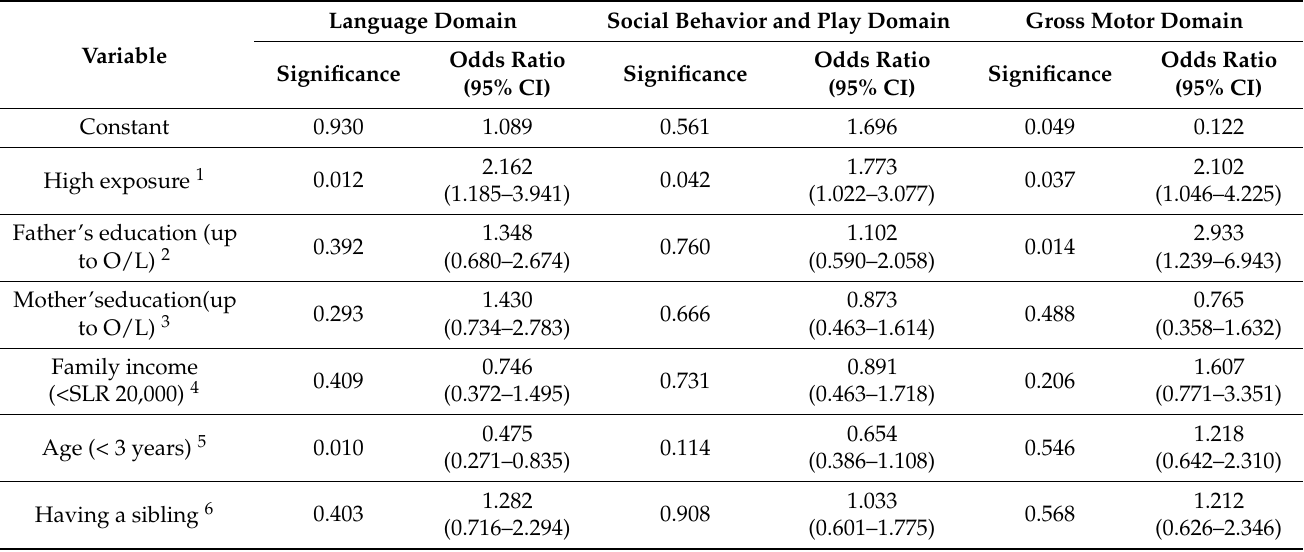
Table 2. Summary of logistic regression analysis for language development assessment.